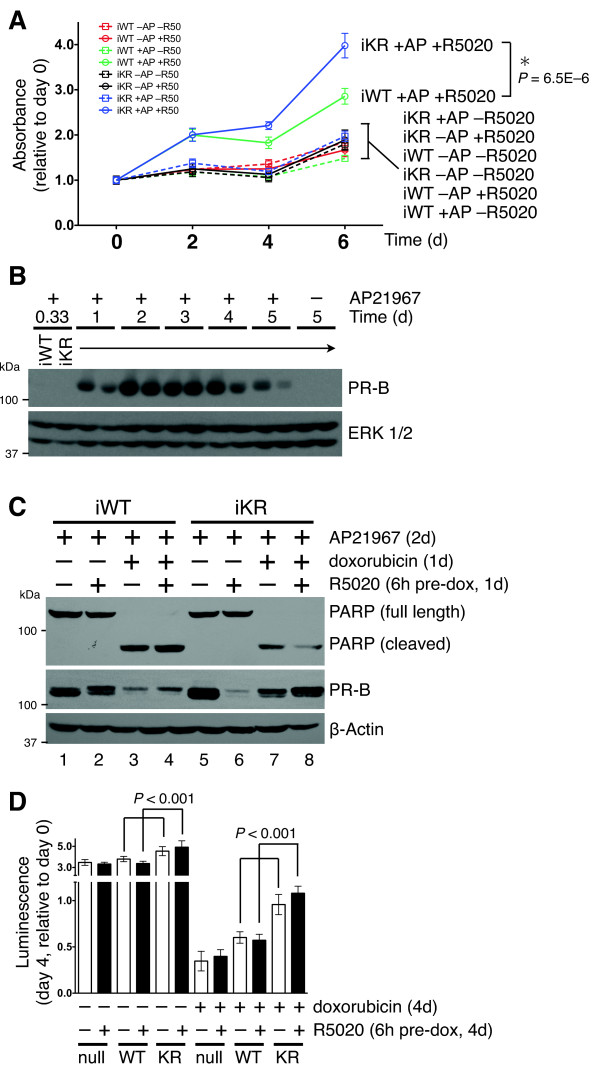
SUMO-deficient progesterone receptors promote increased cell proliferation and decreased apoptosis. (A) The proliferative potential of T47D cell lines expressing inducible PR was measured using MTT assays in the presence of progestin (R5020) and inducer, AP21967 (AP) (B) Western blot showing that inducible PR expression is sustained for at least five days following the addition of AP21967 to the cell culture media, ERK1/2 western blotting was performed as a loading control. (C) Apoptosis occurring in cells expressing inducible PRs was detected by western blotting for poly (ADP)-ribose polymerase 1 (PARP) cleavage. Cells were treated with progestin and/or doxorubicin before protein harvest. (D) Proliferation and apoptosis was measured in cells constitutively expressing PR using cell viability luciferase assays, where day 4 luminescence was normalized to day 0. Pooled data are represented as mean of n = 6 +/- SD and significance calculated using Student's t-test. MTT, 3-(4,5-dimethylthiazol-2-yl)-2,5-diphenyltetrazolium bromide; n, number; PR, progesterone receptor; SD, standard deviation; SUMO, small ubiquitin-like modifier.